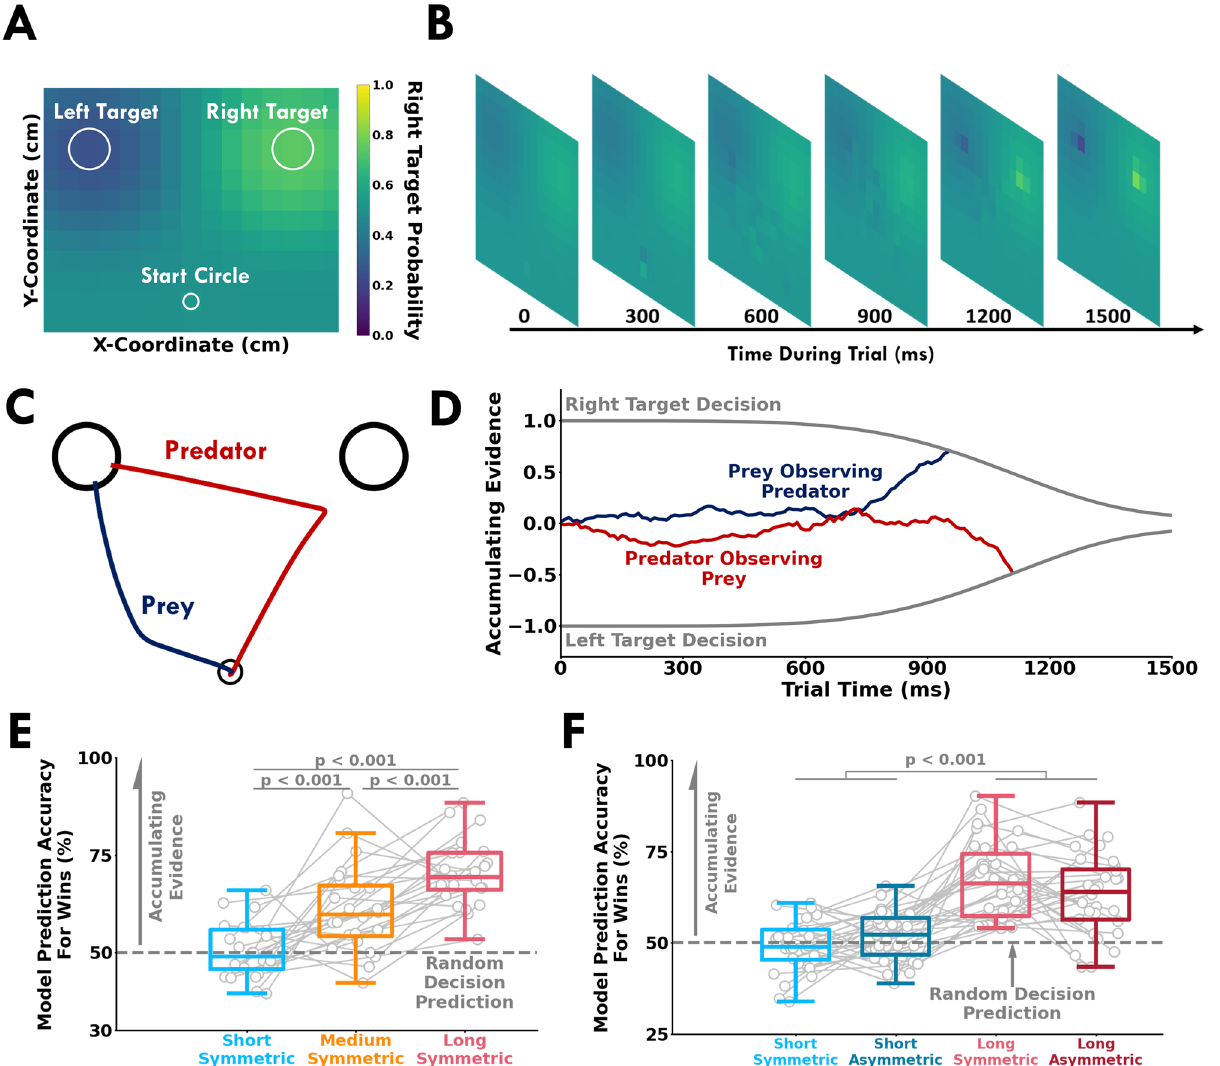
Figure 8. Computational model. The probability of selecting the right target was estimated by discretizing the ( A ) workspace over ( B ) time. Each discretized area was characterized by a beta distribution that sampled the probability an opponent would select the right target ( p right ) given the current location of their cursor. The sampled right target selection probability was used as evidence for the drift-diffusion model. ( C ) Sample hand trajectories of a human pair from a trial in the long-symmetric condition. ( D ) Drift-diffusion model showing accumulation of evidence using the hand trajectories shown in ( C ). The drift-diffusion model accumulates sensory evidence of the opponent’s actions to predict the opponent’s target selection. The model predicts a right or left target selection once the accumulated sensory evidence respectively crosses the upper or lower target decision boundary. A target was selected for the participant based on their role and the predicted target selection for their opponent. For the example shown, the predator observed the prey’s cursor [dark blue trace in ( C )] and accumulated evidence [dark red trace in ( D )] that the prey will select the left target (the dark red line crossed the left target decision bound). The predator then correctly selected the left target to win the trial. Conversely, the prey observed the predator’s cursor [dark red trace in ( C )] and accumulated evidence [dark blue trace in ( D )] that suggested the predator would go to the right target (the dark blue line crossed the right target decision bound). The prey made a wrong decision based on early accumulated evidence and incorrectly selected the left target in a failed attempt to avoid the predator. Here the drift-diffusion model correctly predicted a left target selection for both the predator and prey. Model prediction accuracy ( y-axis ) for successful decisions in ( E ) Experiment 1 and ( F ) Experiment 2. Model prediction accuracy is the proportion of trials where the predicted decision for a participant matched the observed decision. The open gray circles and connecting gray lines correspond to individual participants. Box plots show 25th, 50th, and 75th percentiles. As expected, the model made random decision predictions ( ≈ 50%, grey dashed line) in the short trial conditions because there was not enough time to accumulate evidence. Conversely, with more available time to accumulate evidence in the longer trial conditions, the model predicted a participant’s successful behaviour with greater